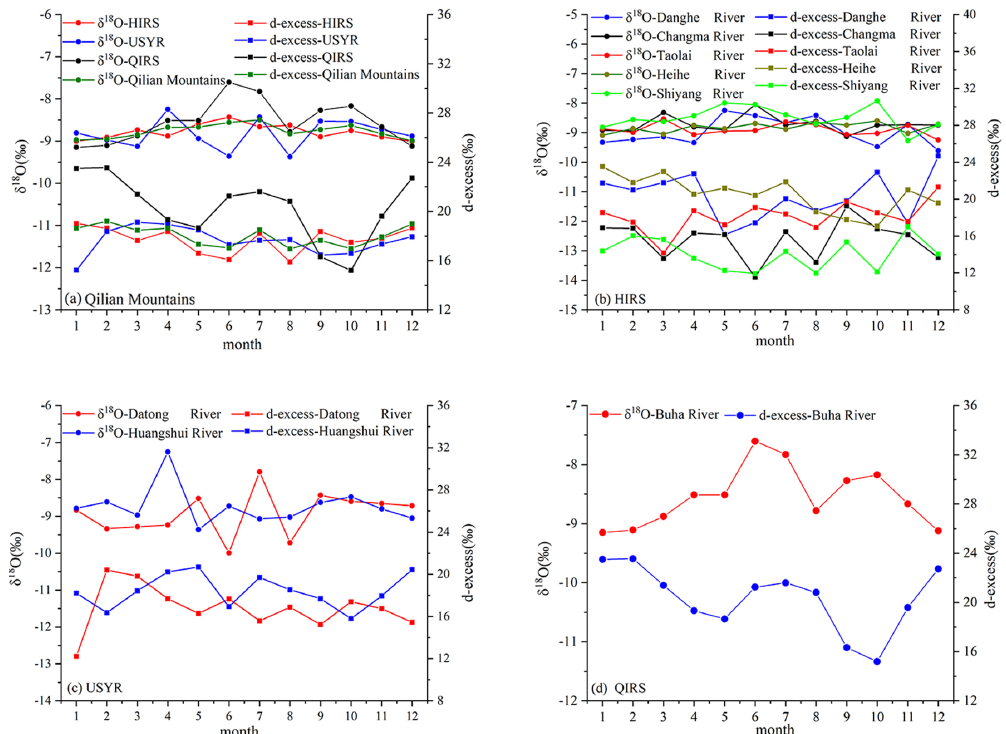
Figure 7. Stable isotope characteristics of groundwater in the Qilian Mountains.